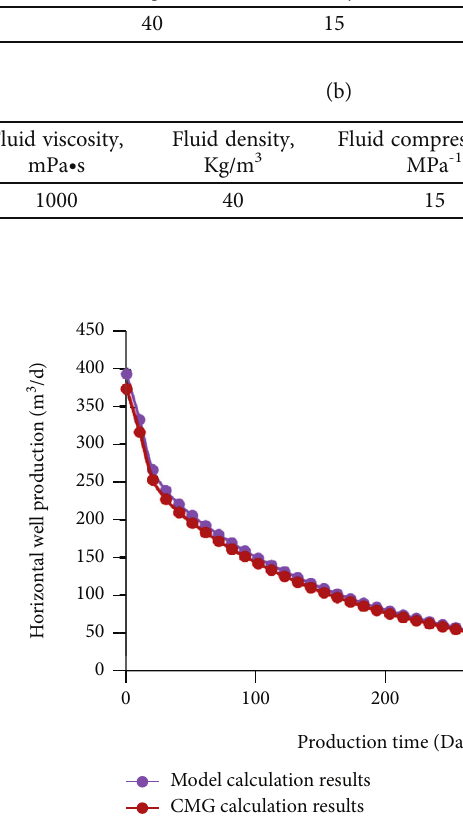
Figure 3: Comparison between the calculation results of the model and CMG software.